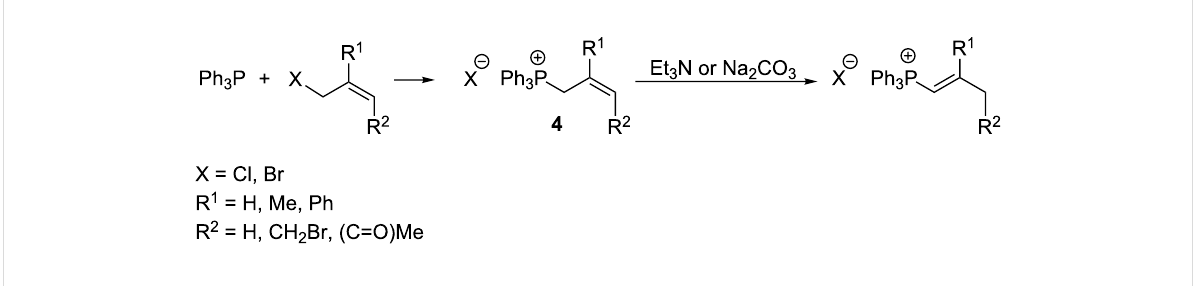
Scheme 5: Alkylation of phosphines with allyl halide derivatives and subsequent isomerization of intermediate allylphosphonium salts.